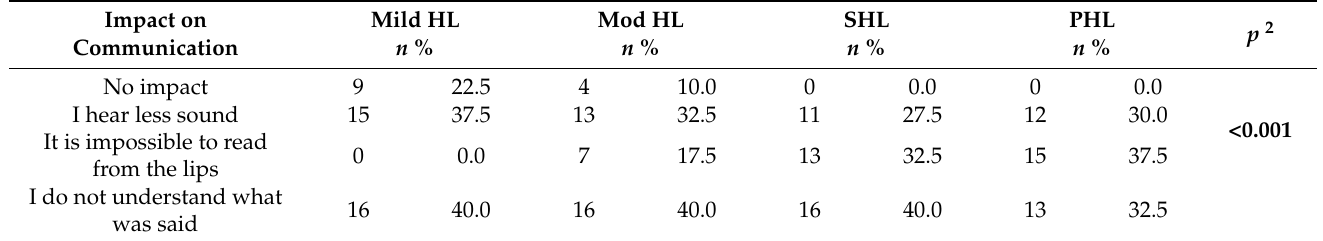
Table 4. Relation between the degree of hearing loss and the type of communication difficulties caused by face